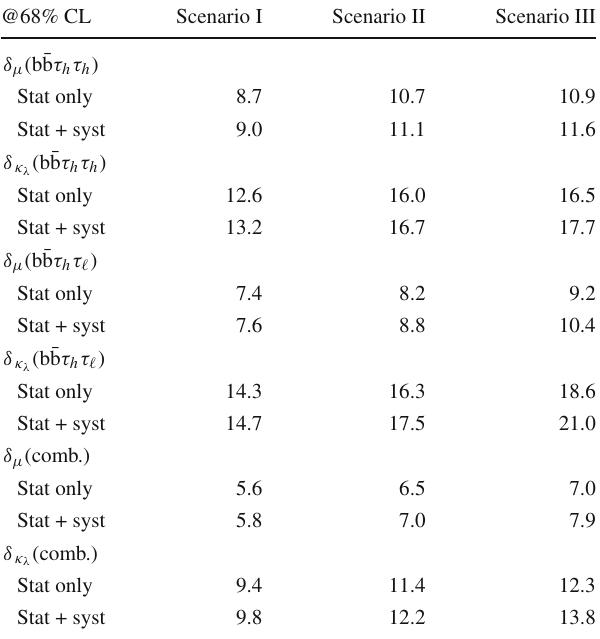
Table 5 Expected precision at 68% CL on the di-Higgs production cross-section and Higgs self coupling using the b ¯ b ττ channel at the FCC-hhwith L int = 30 ab − 1 .Thesymmetrizedvalue δ = (δ + + δ − )/